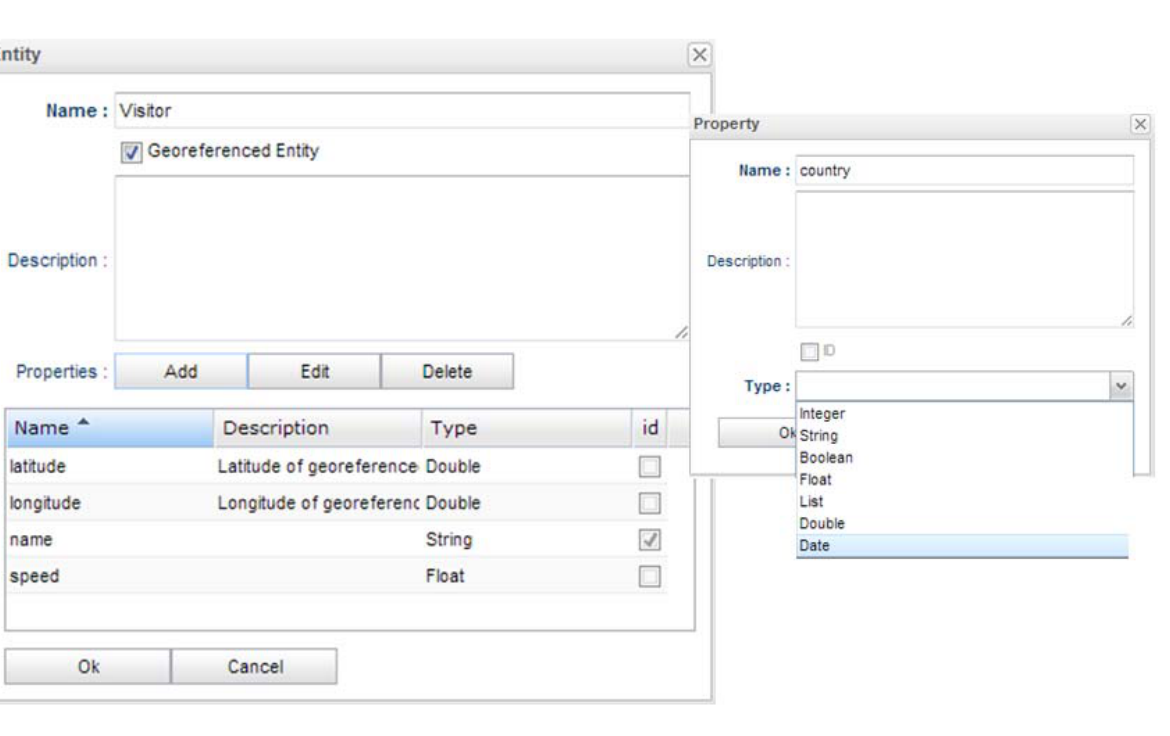
Figure 6. Entity creation